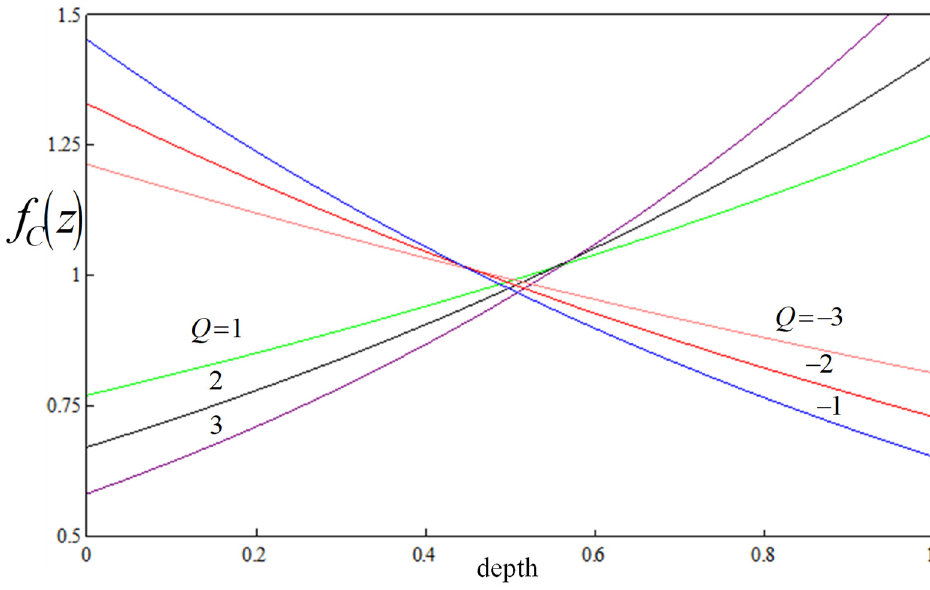
( ) depth , taking different values of throughflow parameters with Figure 3. Plot of C f z with = 10, Da = 0.1, ξ = 0.5, η = 0.5 and δ = 0.5. 0.5, = Le 10, = Rs 0.1, = Da 0.5, 0.5 ξ η= = and 0.5. δ= Rs